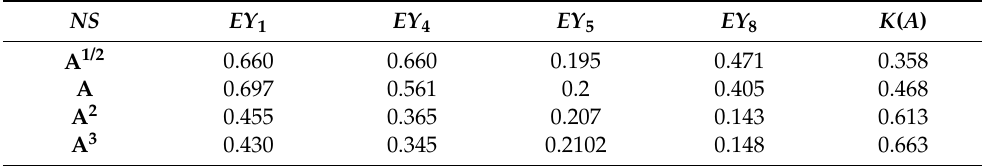
Table 12. Computed entropies/knowledge measures of